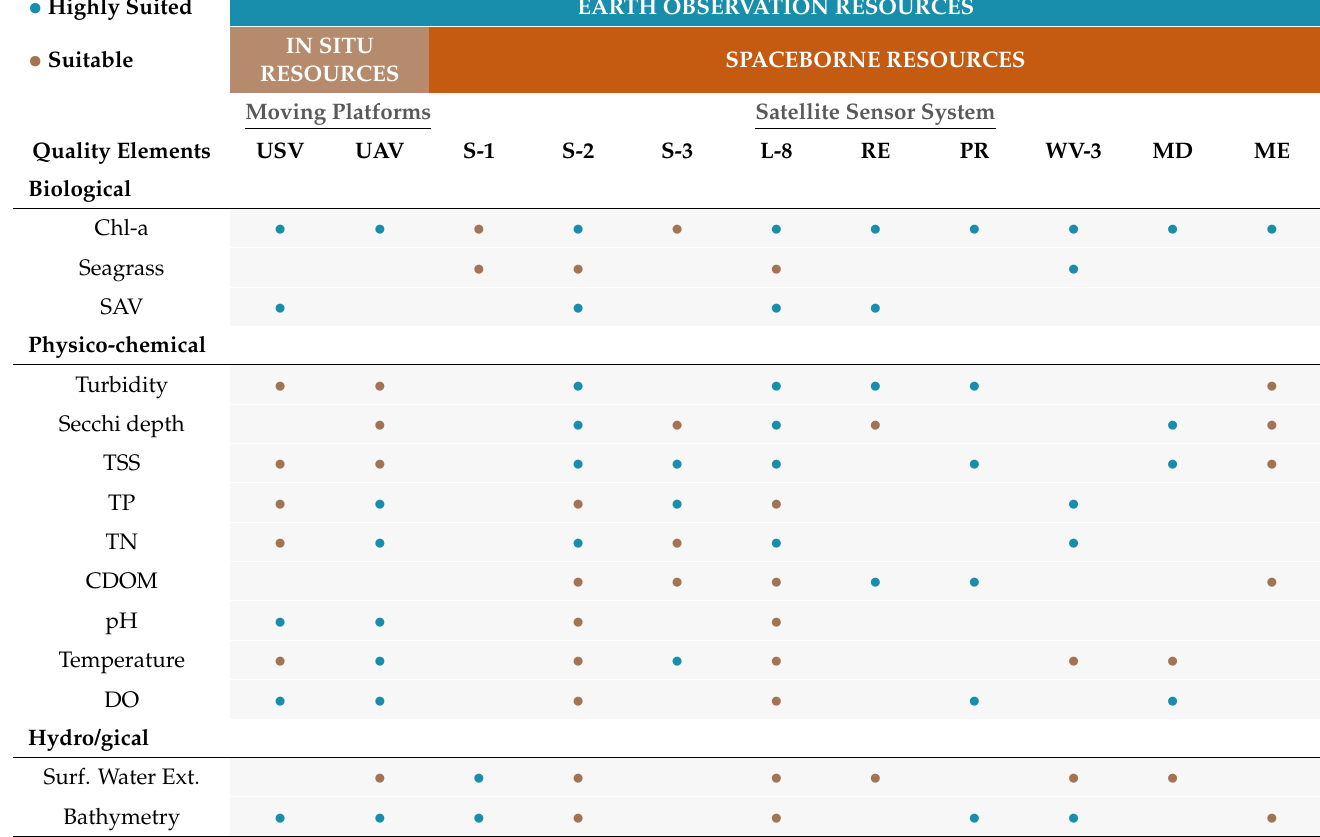
Table 6. The general dynamics of the main spaceborne and in situ resources for selected mandatory WFD QEs based on this review. (In moving platforms columns, USV = Unmanned Surface Vehicles and UAV = Unmanned Aerial Vehicles, while in Satellite Sensor System columns, S =